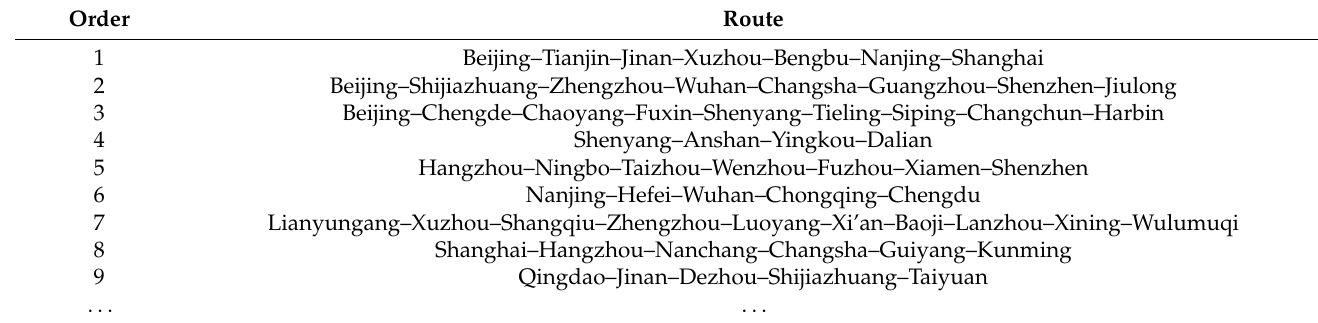
Table 1. Example of